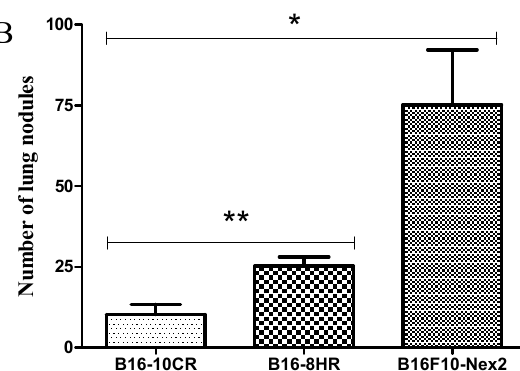
Figure 1. Clones with different metastatic properties were isolated from the B16F10-Nex2 murine melanoma cell line. ( A ) Local subcutaneous tumor development in syngeneic C57Bl/6 mice following injection with the B16F10-Nex2 cell line ( n = 5) and clones B16-10CR ( n = 4) and B16-8HR ( n = 5), isolated by limiting dilution from B16F10-Nex2 cells. Tumor size is plotted separately for each animal; ( B ) The number of lung nodules in C57Bl/6 mice 15 days after intravenous inoculation with the B16F10-Nex2 cell line and clones B16-10CR and B16-8HR ( n = 4 for all). The mean and standard deviation of each group is presented. * p = 0.0061; ** p = 0.0108.